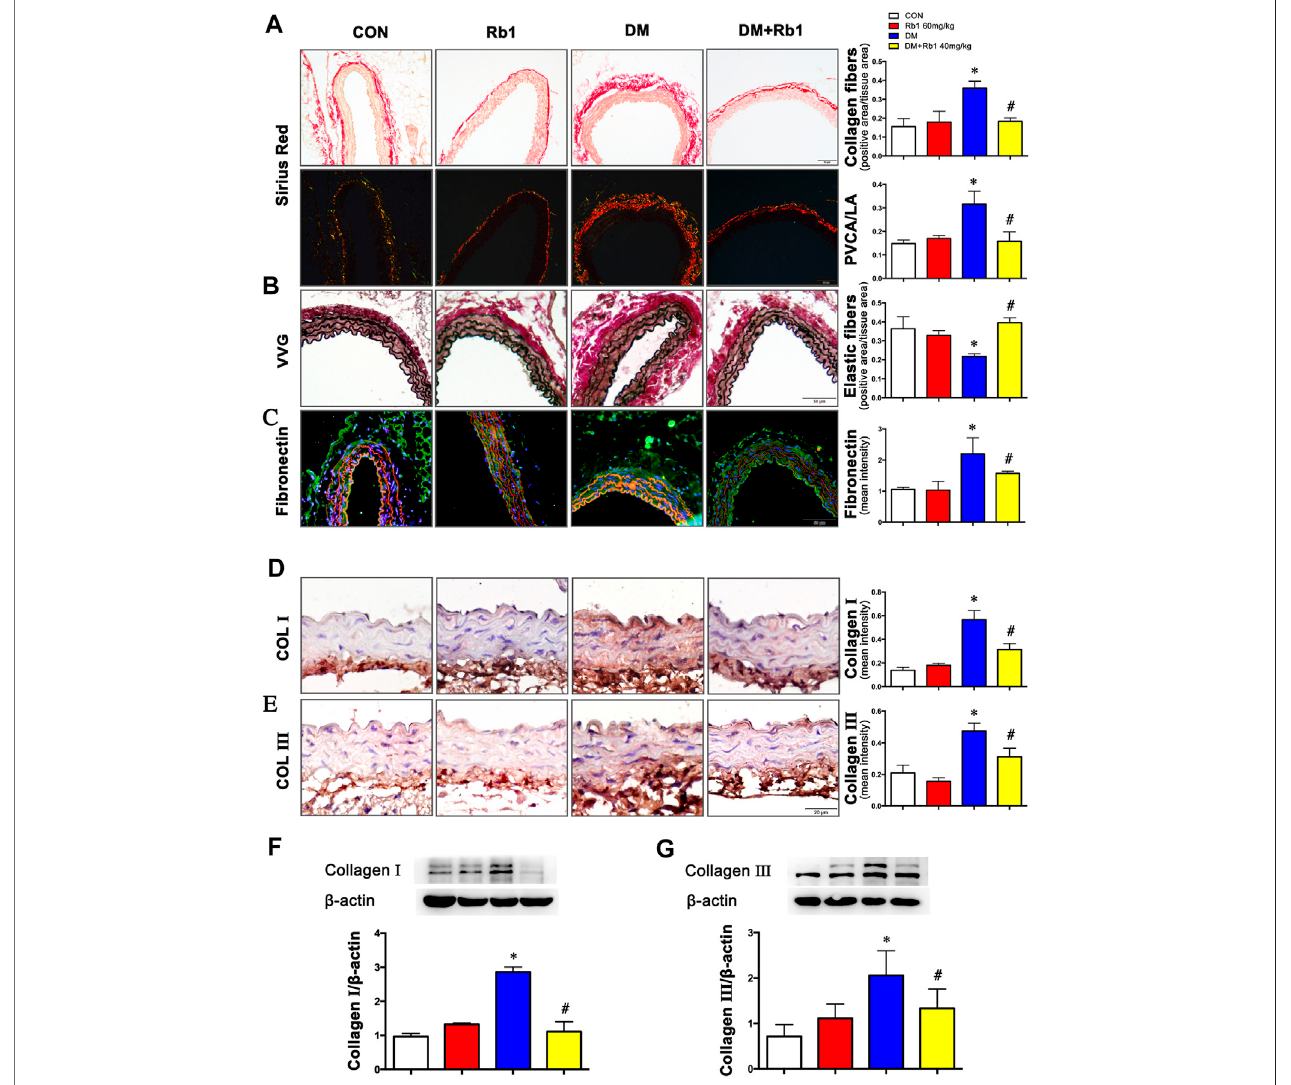
FIGURE2| Rb1reducesDM-inducedaorticremodeling (A) Siriusredstaining(bright fi eldanddark fi eld)(scalebar50 μ m).Collagen fi berswerestainedbrightred. Semiquantitativeanalysisofcollagen fi bers.Perivascularcollagencontent,shownastheperivascularcollagenarea/luminalarea(PVCA/LA)ratio. (B) Elastic fi bersshown by Verhoeff-Van Gieson staining (scale bar 50 μ m). Elastic fi bers are black, VSMCs are light red, and collagen fi bers are pink. Semiquantitative analysis of elastic fi bers. (C) Fibronectin accumulation (green: fi bronectin, red: elastic lamina, blue: nuclei, scale bar 50 μ m). Semiquantitative analysis of fi bronectin expression. Representative immunohistochemical staining (D) , Western blot bands (F) , and semiquantitative analysis of collagen I expression (scale bar 20 μ m). Representative immunohistochemical staining (E) , Western blot bands (G) , and semiquantitative analysis of collagen Ⅲ expression (scale bar 20 μ m). Data are mean ± SEM. n (cid:2) 5 – 6, * p < 0.05 vs. Control; # p < 0.05 DM + Rb1 vs. DM.